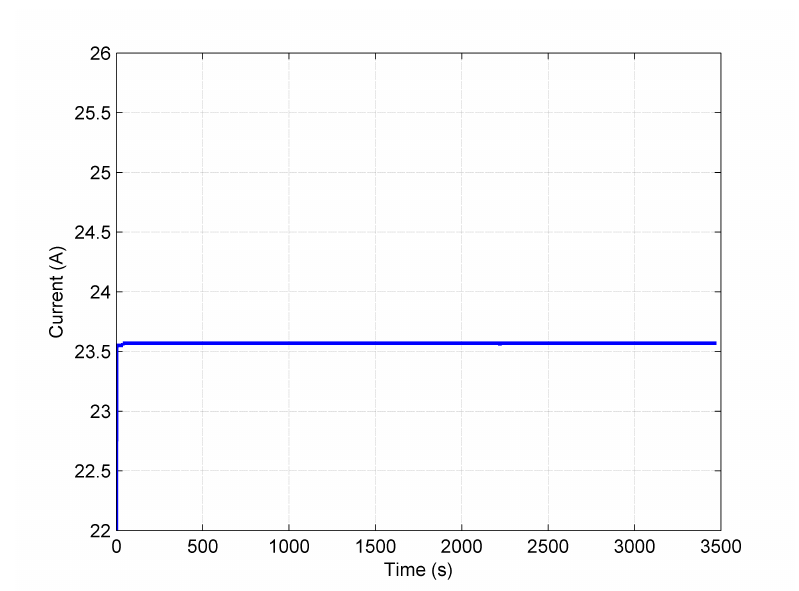
Figure 6. Static experimental validation current profile.